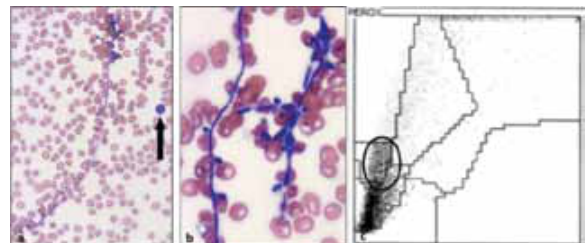
Fig. 1. Peripheral blood smear from a 5-year-old HIV-1-positive girl, showing marked fungaemia: a – size of fungal element in relation to lymphocyte (arrow); b – closer view of fungal elements, showing oval yeast forms with blastoconidia and pseudohyphae; c – peroxidase channel on ADIVA 2120 analyser. The encircled area depicts the region where lymphocytes are typically noted based on both size and peroxidase negativity. In this instance, these events are produced by yeast cells rather than